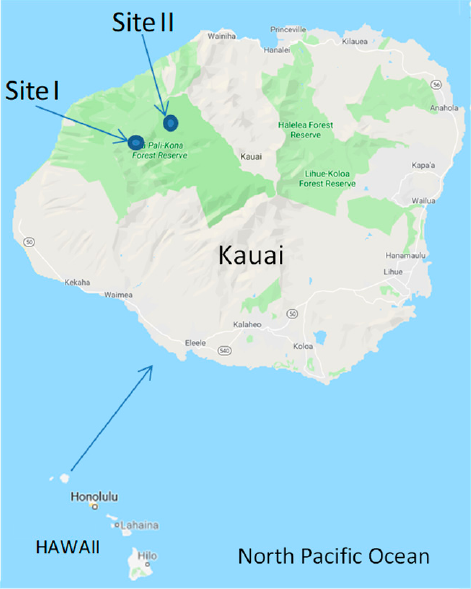
Figure 1. Locations of study areas in Kauai, Hawaii, the Pacific Ocean.